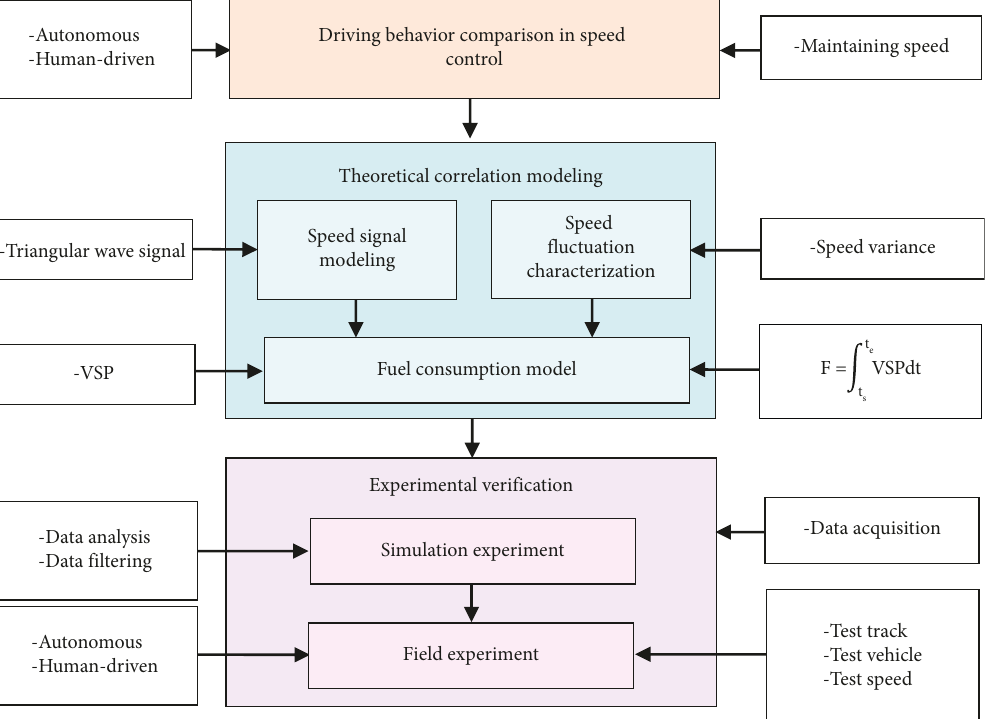
Figure 1: Research